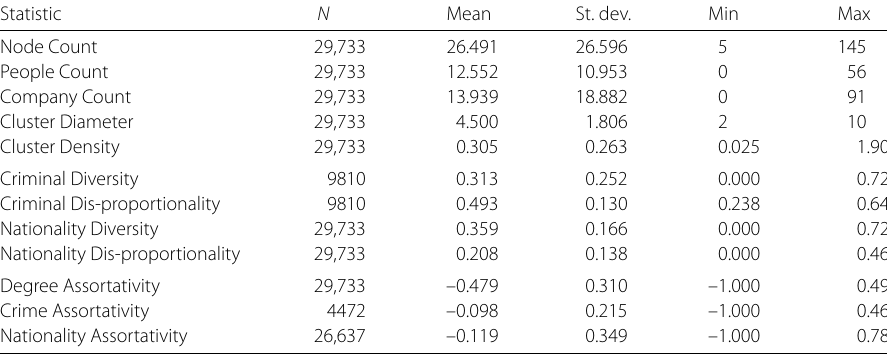
Table 2 Cluster-level summary statistics